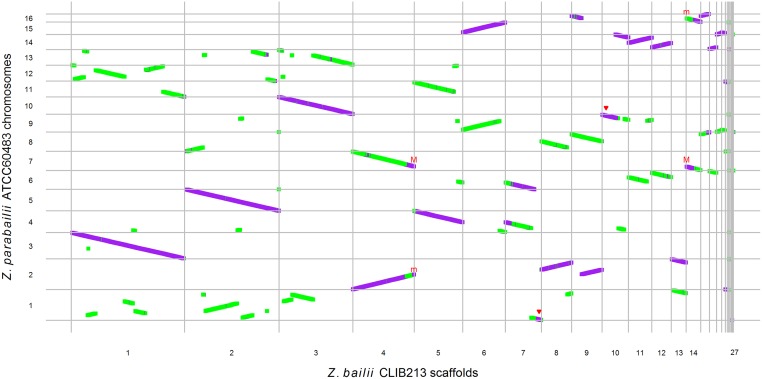
Dot-matrix plot between Z. bailii CLIB213T scaffolds [38] and Z. parabailii ATCC60483 chromosomes.Each dot is a protein-coding gene (purple: A-genes; green, B-genes). Red triangles indicate chromosome ends that appear unpaired due to break-induced replication (BIR). “M” and “m” indicate the active and broken MAT loci of Z. parabailii, respectively.